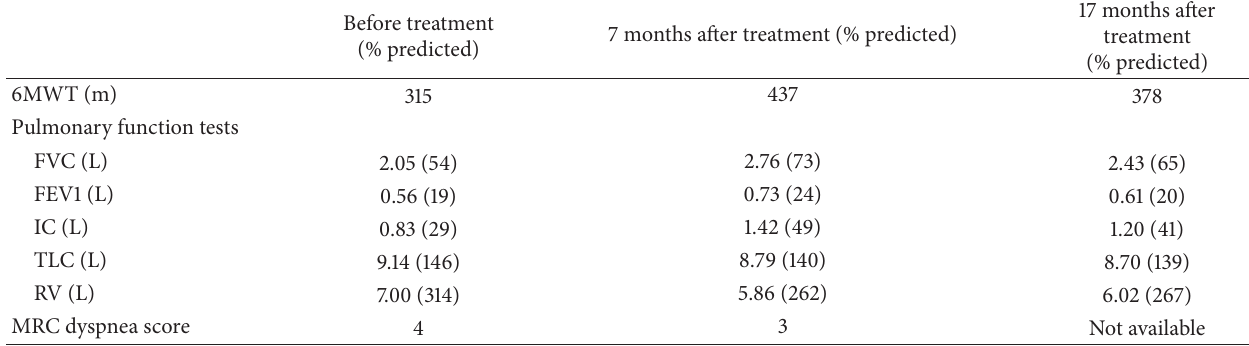
Table 1: Investigation results before treatment and at 7 months and 17 months after treatment. Before